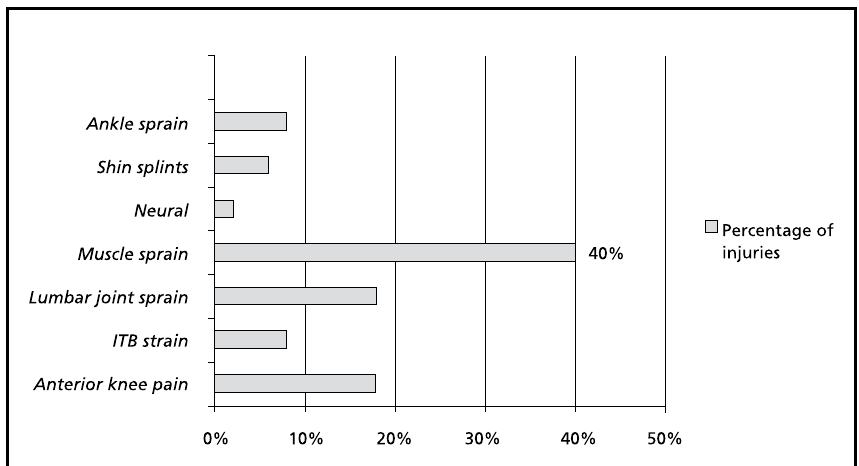
Figure 1: common anatomical sites of previous running injuries